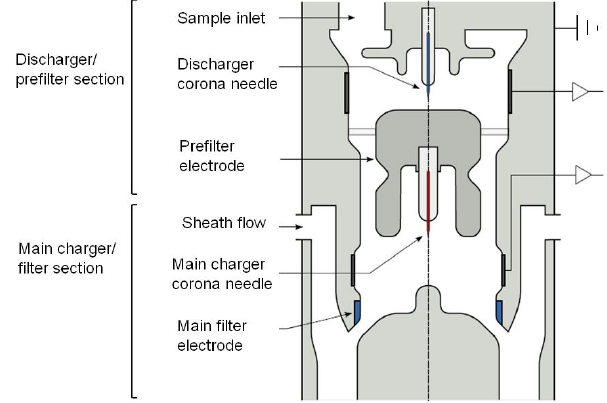
Fig. 1. A schematic cross section diagram of the NAIS aerosol pro- Figure 1. A schematic cross section diagram of the NAIS aerosol processing unit including 494 cessing unit including two pairs of corona-needle charger and elec- two pairs of corona-needle charger and electrical filter sections. 495 trical filter 496